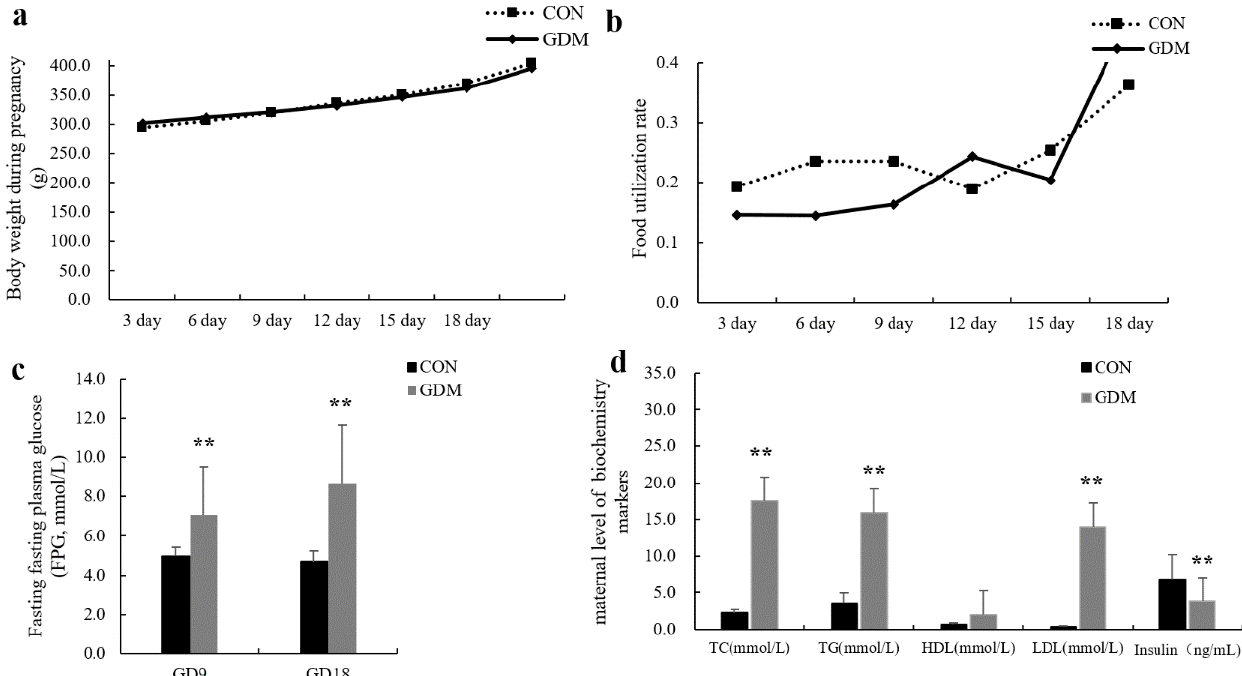
Figure 1. The body weight, food utilization rate, FPG during the gestation, and maternal serum biochemistry markers in CON and GDM. * p < 0.05; ** p < 0.01. ( a ) The line chart of maternal body weight during pregnancy. ( b ) The line chart of maternal food utilization rate during pregnancy. ( c ) The bar chart of fasting plasma glucose in the second and third trimesters. ( d ) The bar chart of maternal level of biochemistry markers.